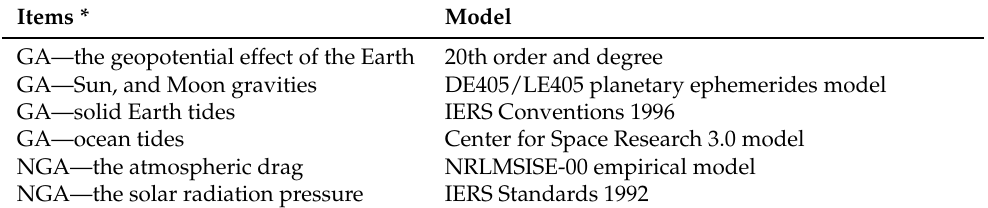
Table 1. Accelerations of gravitational and non-gravitational